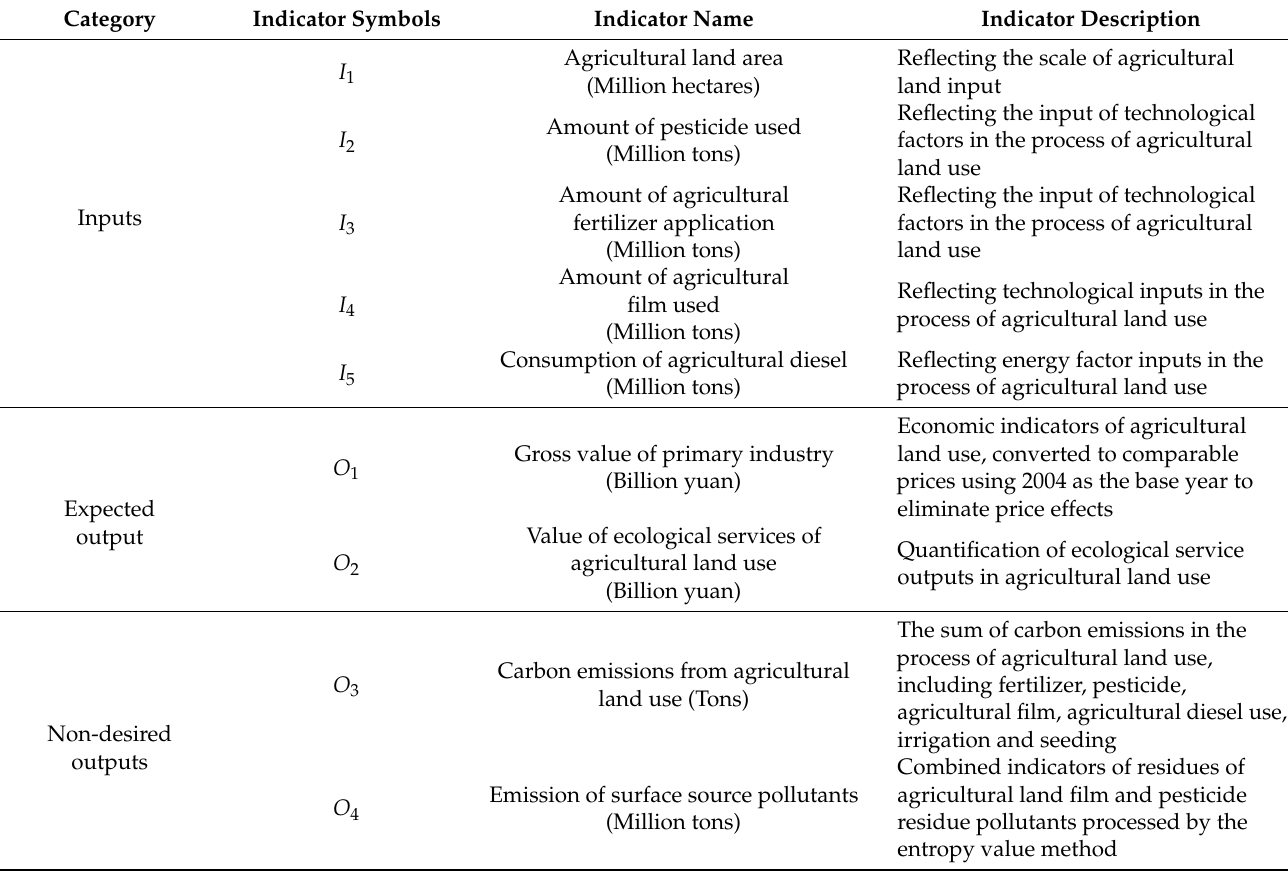
Table 1. Meaning of input–output indicators and descriptive